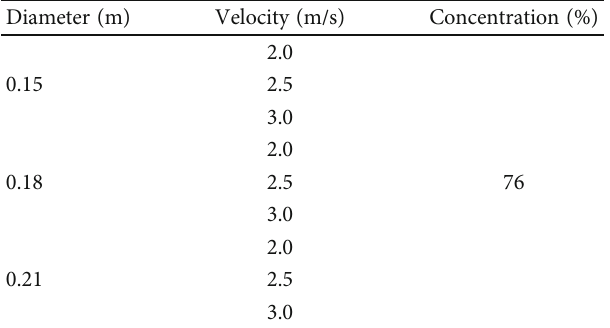
Figure 5: Mesh of the fl uid domain. Table 2: Model